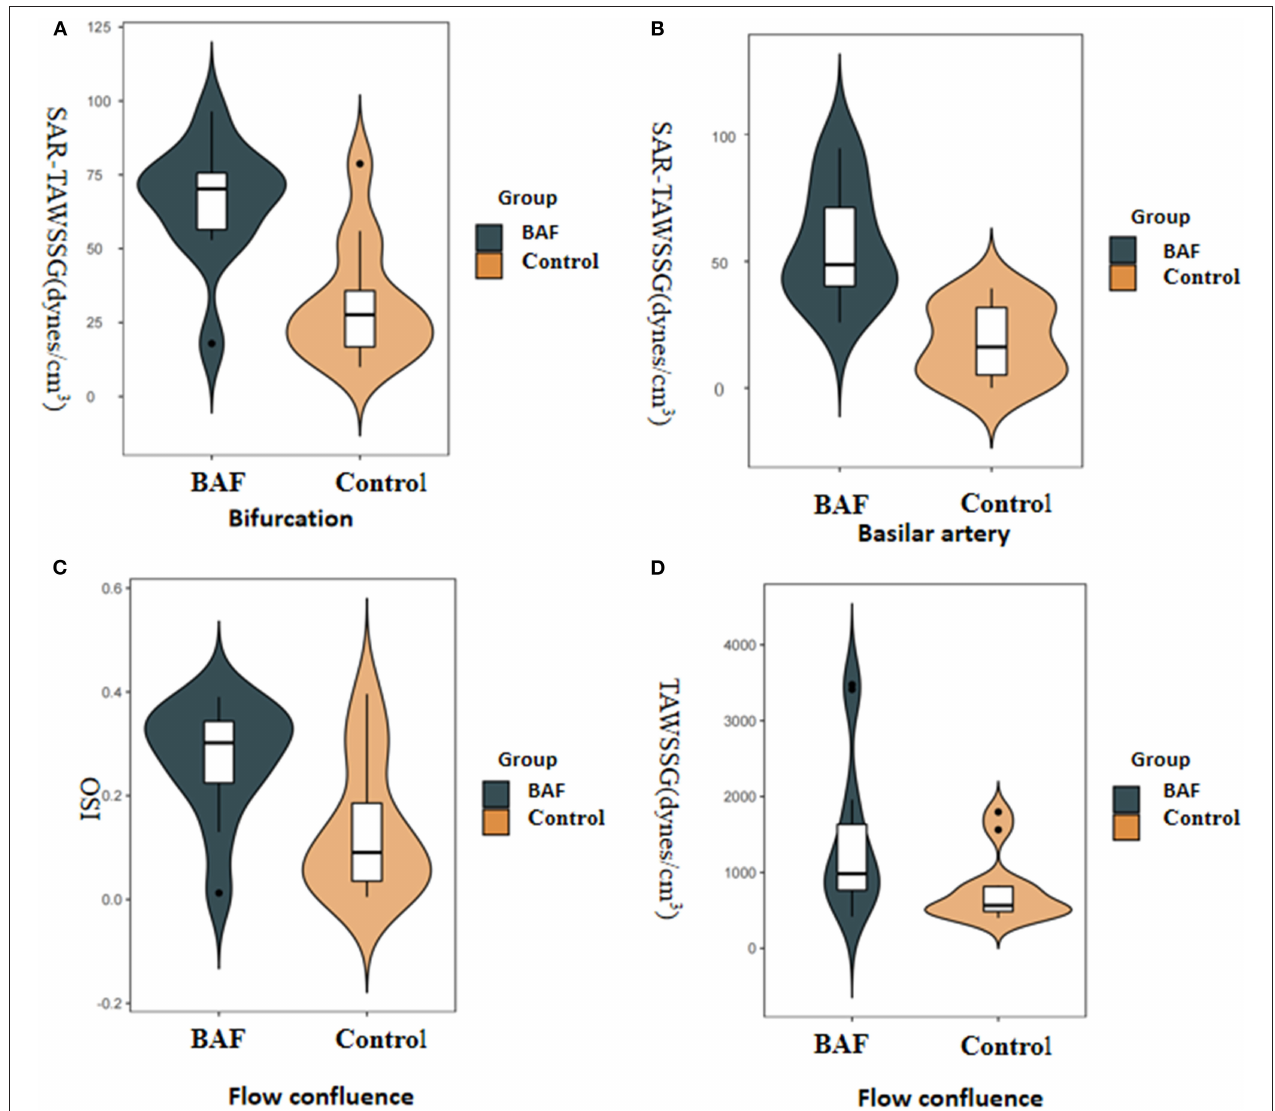
FIGURE 2 | Boxplots displaying the following hemodynamic parameters: surface area ratio-TAWSSG (SAR-TAWSSG), OSI, and TAWSSG for the patients with BAF and those with a normal vertebrobasilar artery (control group). The P -values were obtained from the Wilcoxon rank-sum test. The BAF group had a significantly higher SAR-TAWSSG value in the bifurcation (A) and basilar artery zones (B) than the control group. The BAF group had significantly higher maximum OSI (C) and TAWSSG values (D) than the control group in flow